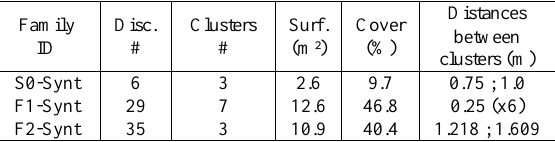
Table 5. Discontinuities Families information computed by